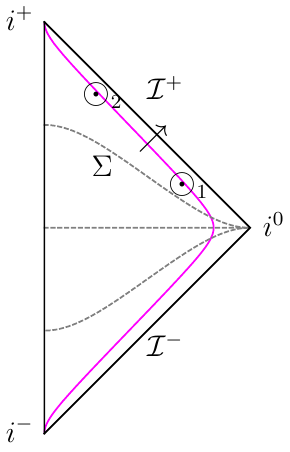
Figure 1 . Observation of memory e(cid:11)ect due to the out-going radiation by massive probes. The (cid:12) 1 ; 2 symbols show detection points, located at constant r . One could set the detection times earlier to observe the in-going memory e(cid:11)ect. The dashed lines depict some Cauchy surfaces and as we see they all intersect at spatial in(cid:12)nity i 0 . In the (cid:12)gure we have implicitly imposed the antipodal matching through i 0 = I + = I (cid:0) (cid:0) +